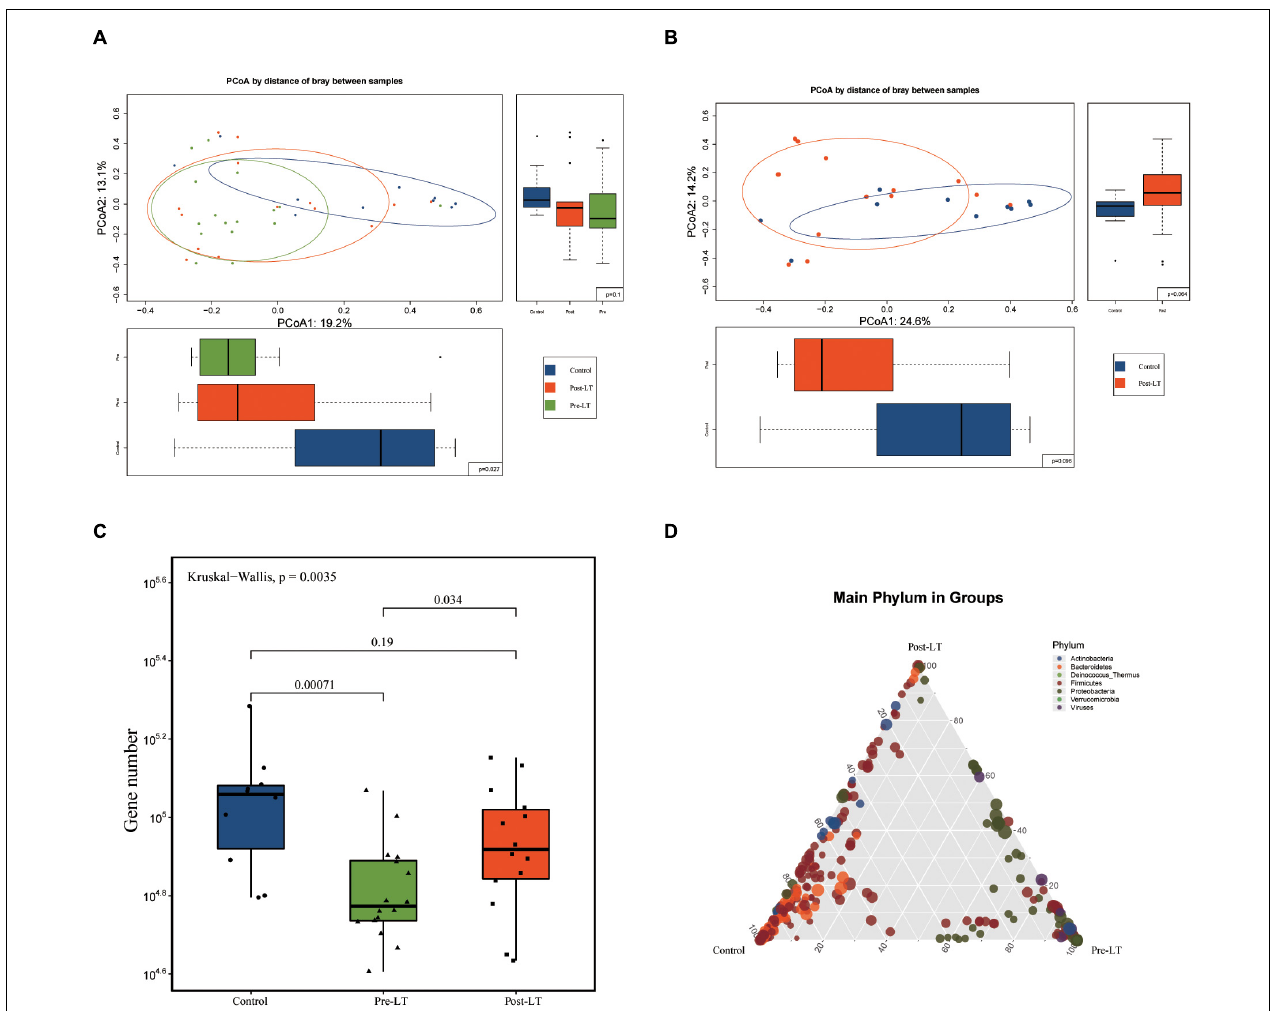
FIGURE 1 | (A) Structural changes in the gut microbiota in pre-LT, post-LT, and control individuals (principal coordinate analysis based on the Bray–Curtis distance of species abundance). (B) Structural changes in the gut microbiota in pre-LT and post-LT individuals (principal coordinate analysis based on the Bray–Curtis distance of species abundance). (C) Different gene numbers between the three groups (Wilcoxon rank-sum test). (D) Ternary plot of different species. The three vertices represent the three different groups, the points represent the different species at the species level, and the size of the points represent the average abundance in the three groups of samples. Points that are enriched in a certain color at a vertex indicate higher species abundance at the phylum level represented by the color in the grouping.